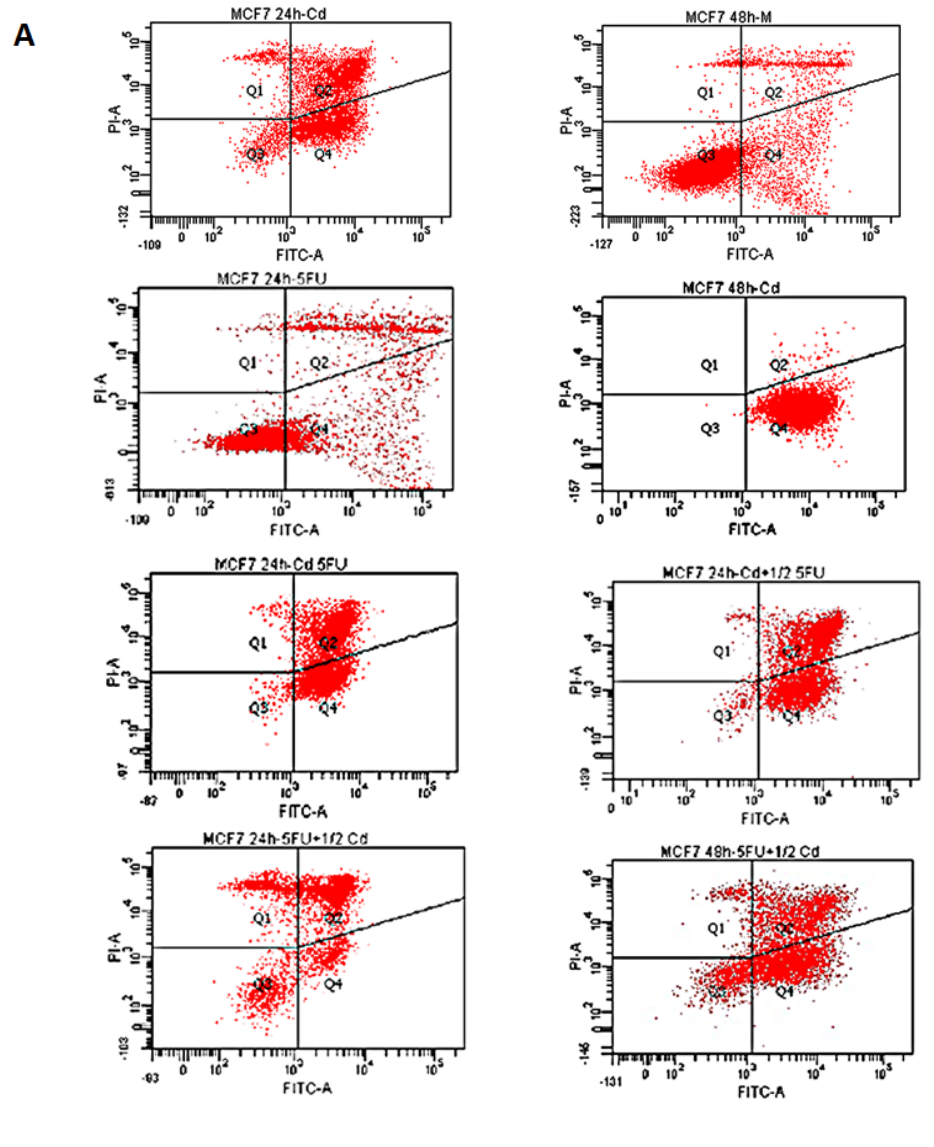
added only at the half time from the experiment started (5FU½Cd) where this increase was not statistically significantly (70.1% ± 3.02% and 81.9% ± 2.34%, respectively; p = 0.0059) (Figure 1). Figure 1. FACScan analysis via Annexin V-FITC/PI staining was used to observe the induction of apoptosis in MCF-7 cells at high doses. ( A ) Representative images of the flow cytometry analysis. Cells in the lower right quadrant indicate the percentage of Annexin-positive, early apoptotic cells. Cells in the lower left quadrant indicate the percentage of Annexin-negative/PI-negative, viable cells. Cells in the upper right quadrant indicate the percentage of Annexin-positive/PI-positive, late apoptotic cells. Cells in the upper left quadrant indicate the percentage of PI-positive, necrotic cells; ( B ) Graphic representation of apoptotic levels (early plus late apoptosis) after treatment with Cd and/or 5-FU for 24 and 48 h. Data are expressed as mean ± SEM of three independent experiments. Q,